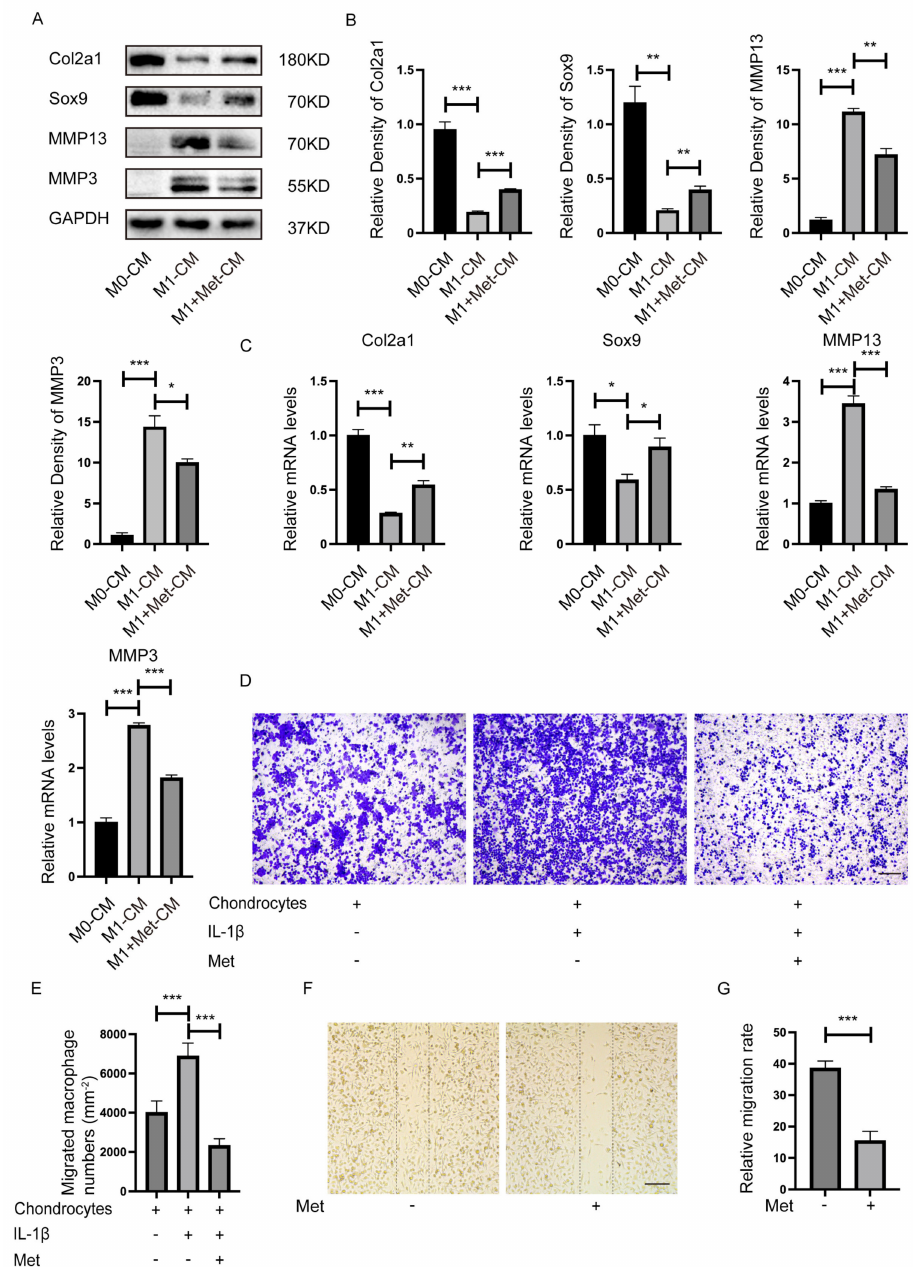
Figure 3. Metformin inhibits the proinflammatory effect and migration of macrophages on chondro- cytes. Primary chondrocytes were cultured with CM from M0, CM (excluding LPS and IFN- γ ) from M1, or CM from M1 macrophages plus metformin (3 mM) in a mixture of DMEM medium (1:1) for 24 h. ( A ) Representative Western blot and ( B ) quantitative analysis of Col2a1, Sox9, MMP13, and MMP3, and ( C ) qRT-PCR determined mRNA levels. ( D ) Representative crystal violet staining images and ( E ) quantification of migrated macrophages. ( F ) Metformin inhibited M1 macrophages migration measured using the scratch wound assay. ( G ) Quantitative analysis of the relative migration rate in ( E ) ( n = 5). Scale bar: 100 µ m. * p < 0.05, ** p < 0.01, *** p <